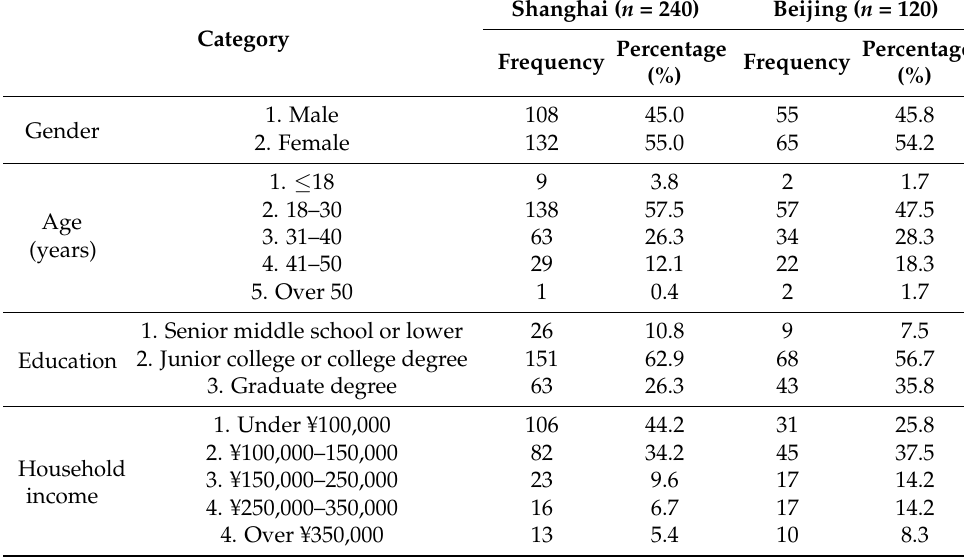
Table 1. Sample characteristics.